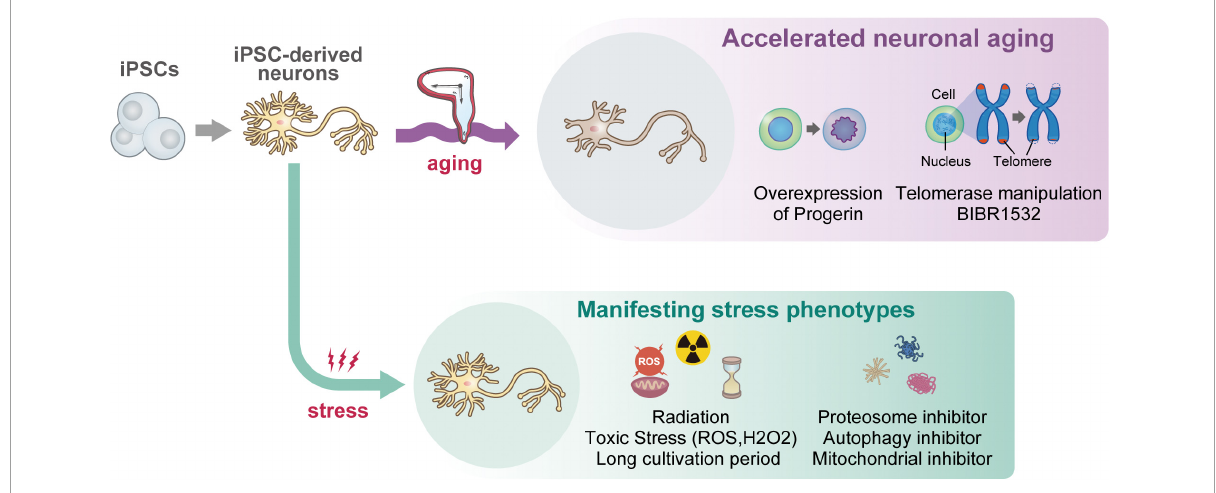
FIGURE1 A graphical schematic of current iPSC-based approaches for reproducing “aging” in vitro . Starting from iPSCs (once rejuvenated), because iPSC-derived neurons themselves show juvenile phenotypes, multiple approaches including overexpression of Progerin, telomere manipulation, and supplementation of stress molecules were attempted so far. Although a recent report succeeded in reproducing age-related nuclear pathology of ALS (Coyne et al., 2020), most attempts were unsuccessful for recapitulating neuropathological features (i.e., neurofibrillary tangle), age-related DNA damage response and methylation, and mitochondrial aging features, which are listed as “Currently infeasible phenotypes” in vitro .